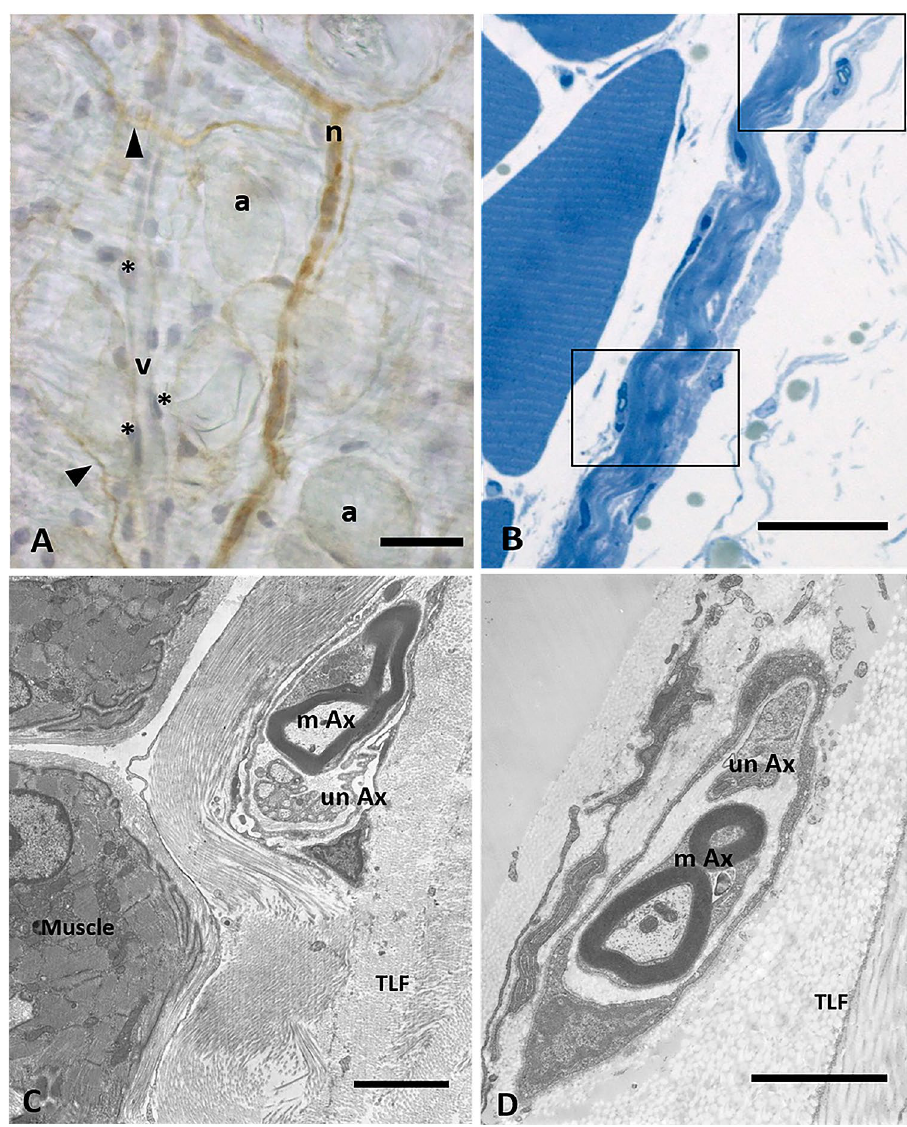
Figure 7. Analysis of nerves inside the fascial tissue: ( A ) Floating thoracolumbar fascia stained with anti-S100 antibody and ematoxylin: the nervous structures are S100 positive (n: small nerve, arrows indicate single nerve fibers), whereas blood vessels are not stained (v: vessel; *: endothelial cells; a: adipocytes). ( B ) Semithin section of thoracolumbar fascia, whose boxes show nerve structures in the midst of collagen bundles of the fascial layers. ( C ) and ( D ): TEM images of a small nerve fiber in the inner layer ( C ) or in the outer layer ( D ) of the TLF, with both myelinc and unmyelinic axons. m: muscle; TLF: thoracolumbar fascia; mAx: myelinic axon; unAx: unmyelinic axon. Scale bars: ( A ) and ( B ) 30 µm; ( C ) 3 µm; ( D ) 2